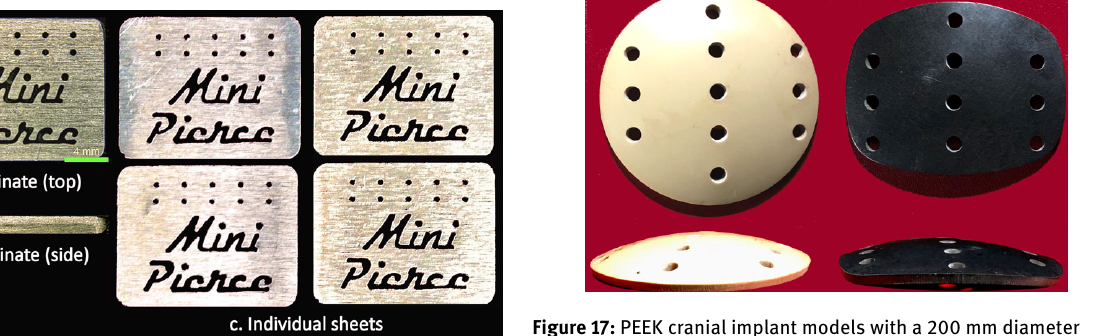
Figure 17: PEEK cranial implant models with a 200 mm diameter spherical